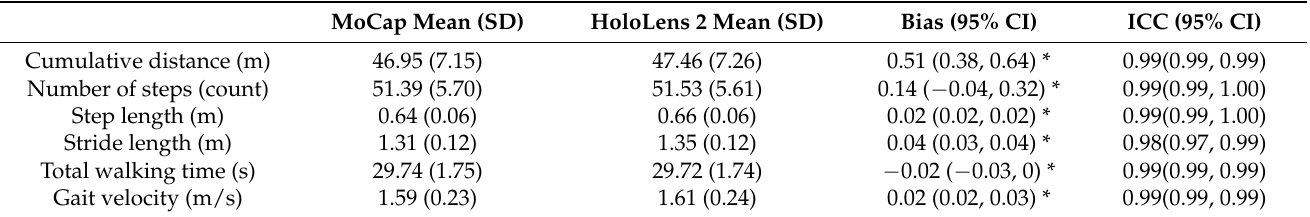
Table 2. Biomechanical outcomes from the MoCap and HL2 systems for continuous walking task.